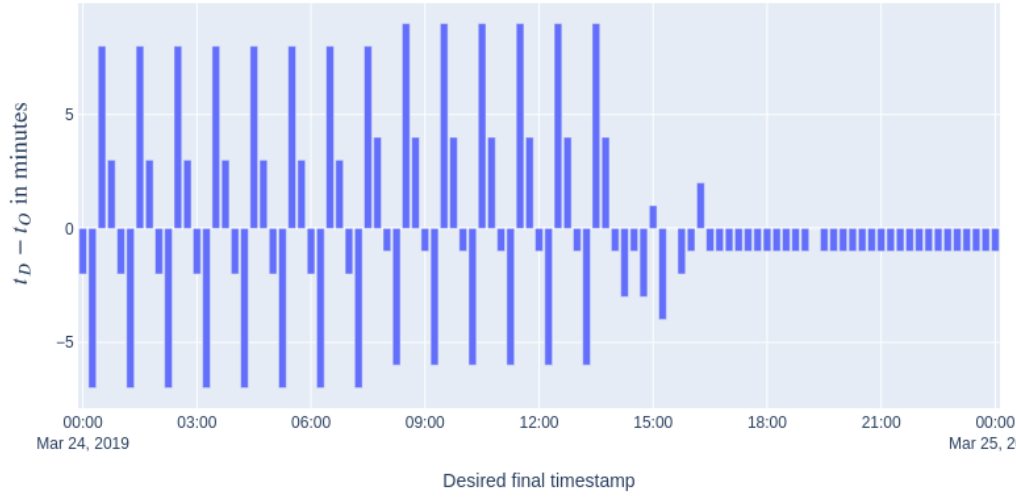
Figure 13. Alignment distortion for feature 14 between y and ˆ y . Negative values in this misalignment imply that anticipated time data has been used in the join, whereas positive values imply delayed time. The difference in the alignment could imply delays in prediction if anticipated data was used in the join or did not really have updated information of the process in order to make an adequate decision.